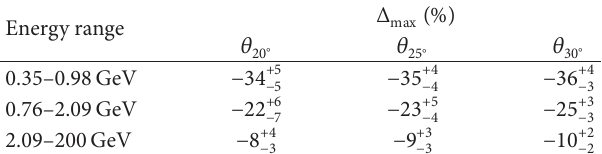
T 5: Differences in percentage between the maximum and ) as a function of the kinetic minimum proton intensities ( energy, using three values for the extension of the polar Δ max